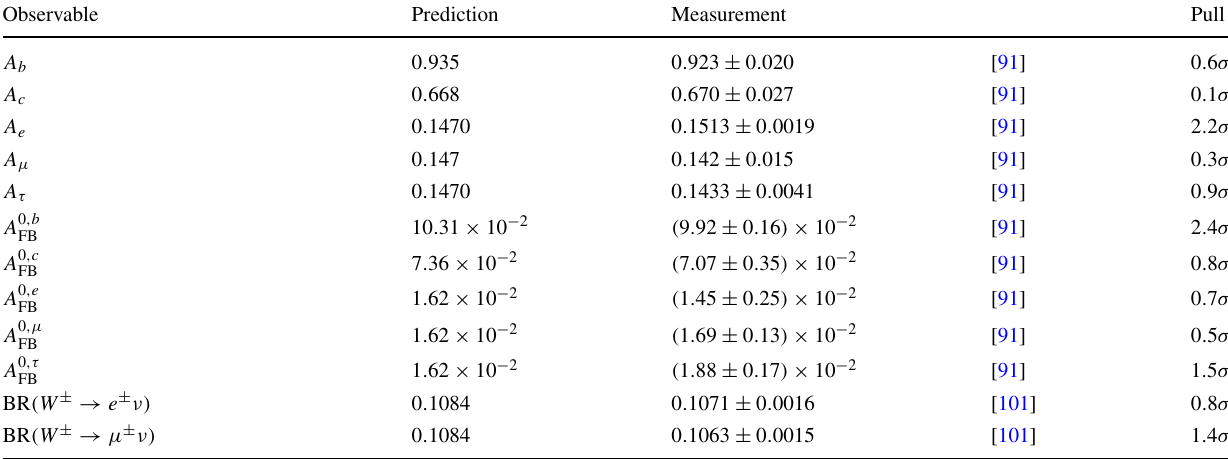
Table 10 Electroweak precision